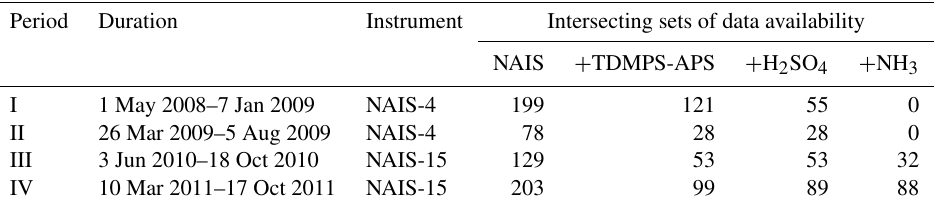
Table 1. Overview of data coverage 2008–2011 encompassing four periods I–IV. The list gives the number of days for which a complete diurnal cycle of NAIS data was available. Further columns indicate the availability of additional parameters, such as the particle number size distribution from the TDMPS-APS, the H 2 SO 4 proxy, and NH 3 . Also, the serial numbers of the two NAIS instruments are indicated. Period Duration Instrument Intersecting sets of data availability NAIS + TDMPS-APS + H 2 SO 4 + NH